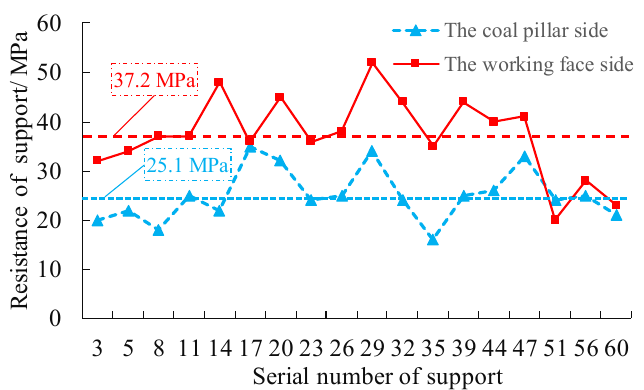
Figure 16. Working resistance of buttress hydraulic supports.